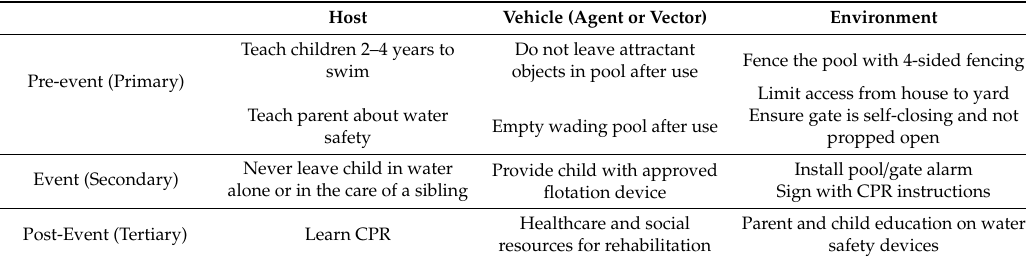
Table 6. Haddon’s Matrix—pediatric